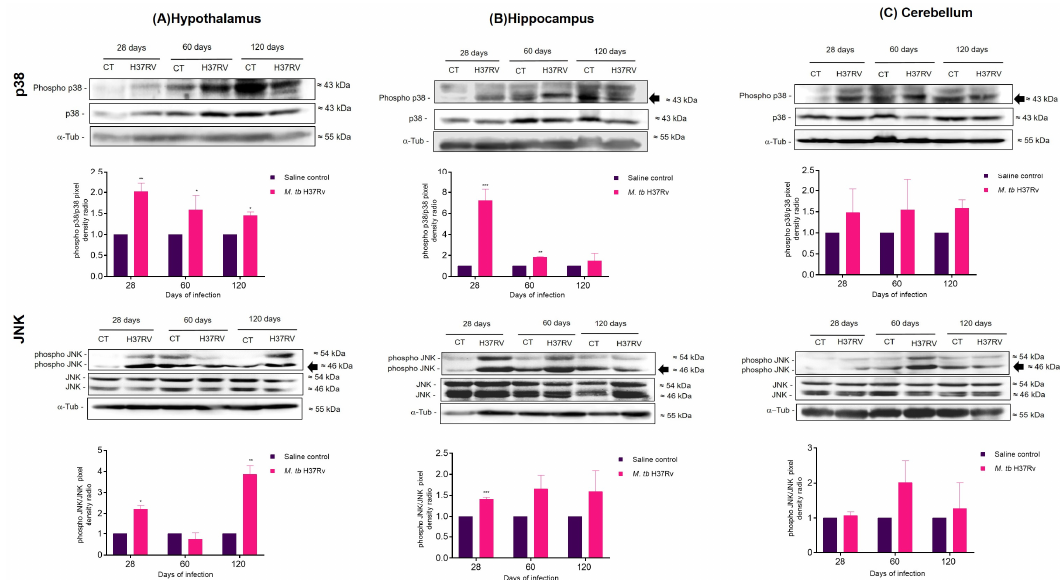
Figure 5. The activation pattern of MAPKs during pulmonary infection with M. tb at 28, 60 and 120 days post-infection in the hypothalamus ( A ), hippocampus ( B ) and cerebellum ( C ). Upper panel shows representative Western blots of activated JNK and p38. Lower panel shows the quantification of the pixel density ratio (PD ratio). There is a tendency to increase the activation of p38 and JNK in the infected mice. Data are expressed as mean ± SEM. p38 Hypothalamus 28 days t = 8.328, ** p = 0.0011, two-tail, unpaired t-test. p38 Hypothalamus 60 days t = 7.428, * p = 0.012, two-tail, unpaired t -test. p38 Hypothalamus 120 days t = 5.19, ** p = 0.0020, two-tail, unpaired t-test. p38 Hippocampus 28 days t = 6.873, *** p = 0.0010, two-tail, unpaired t-test. p38 Hippocampus 60 days t = 16.43, ** p = < 0.0001, two-tail, unpaired t -test. JNK Hypothalamus 28 days t = 8.518, * p = 0.022, two-tail, unpaired t -test. JNK Hypothalamus 120 days t = 9.23, ** p = 0.0027, two-tail, unpaired t -test. JNK Hippocampus 28 days t = 13.75, *** p = 0.0008, two-tail, unpaired t -test ( n = 3).